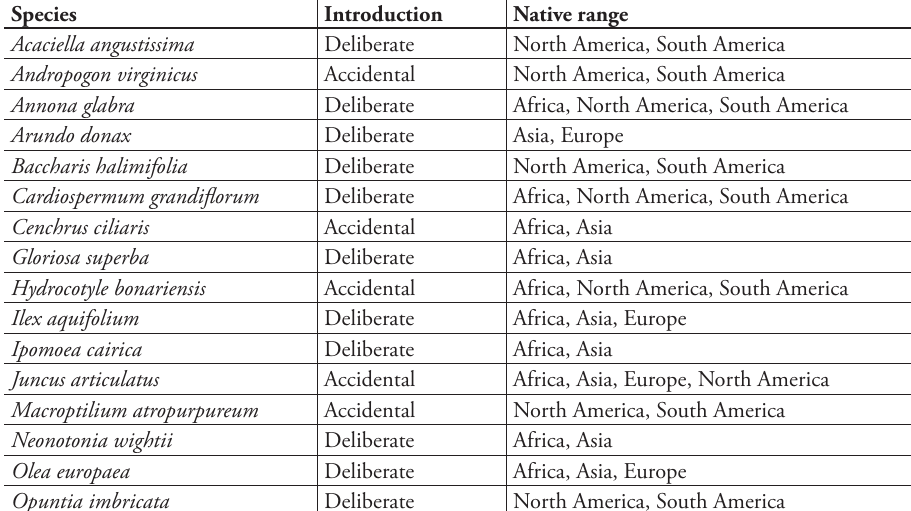
Table 1. Cosmopolitan species, their method of introduction and native geographic ranges.